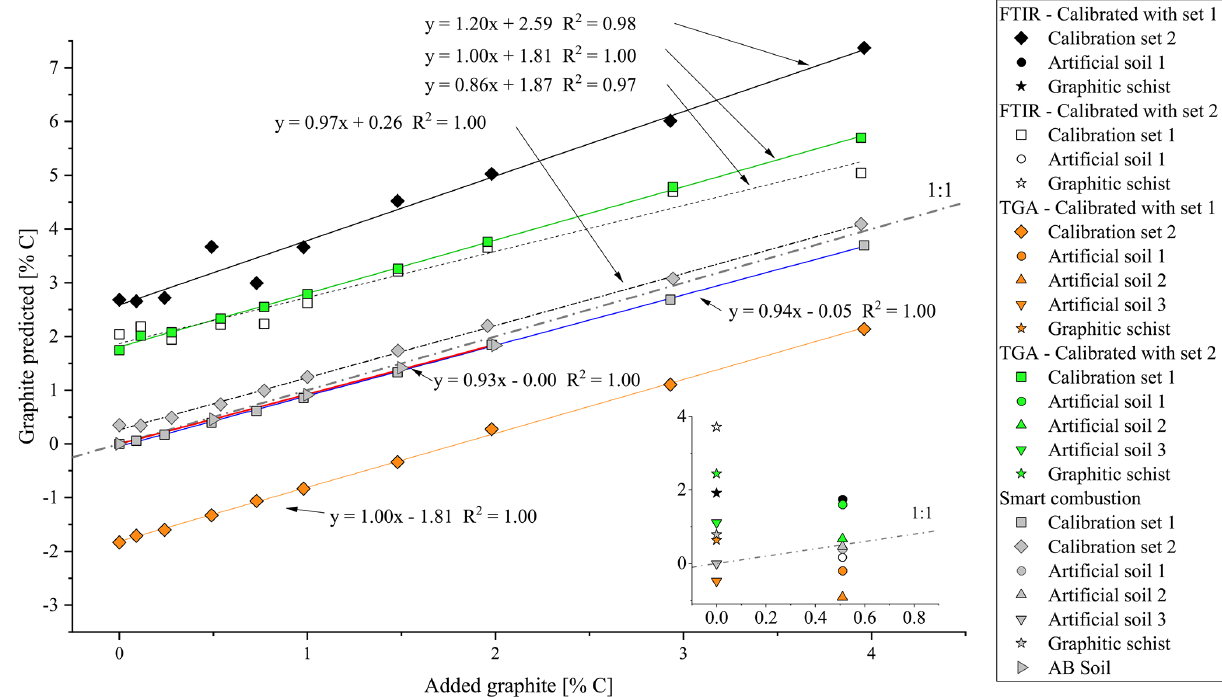
Figure 5. Overview of the predicted amount of graphite in the calibration sets (squares/diamonds), artificial soil (inset, circles/triangle), graphitic schist (inset, stars) and AB soil (right-pointing triangle) as measured with the different methods. Black symbols: graphite prediction by FTIR, model from calibration set 1; white: graphite prediction with FTIR, calibration set 2; orange: graphite prediction by TGA, model from calibration set 1; green: graphite prediction by TGA, model from calibration set 2; grey: graphite prediction by smart combustion. Exact data are given in Table